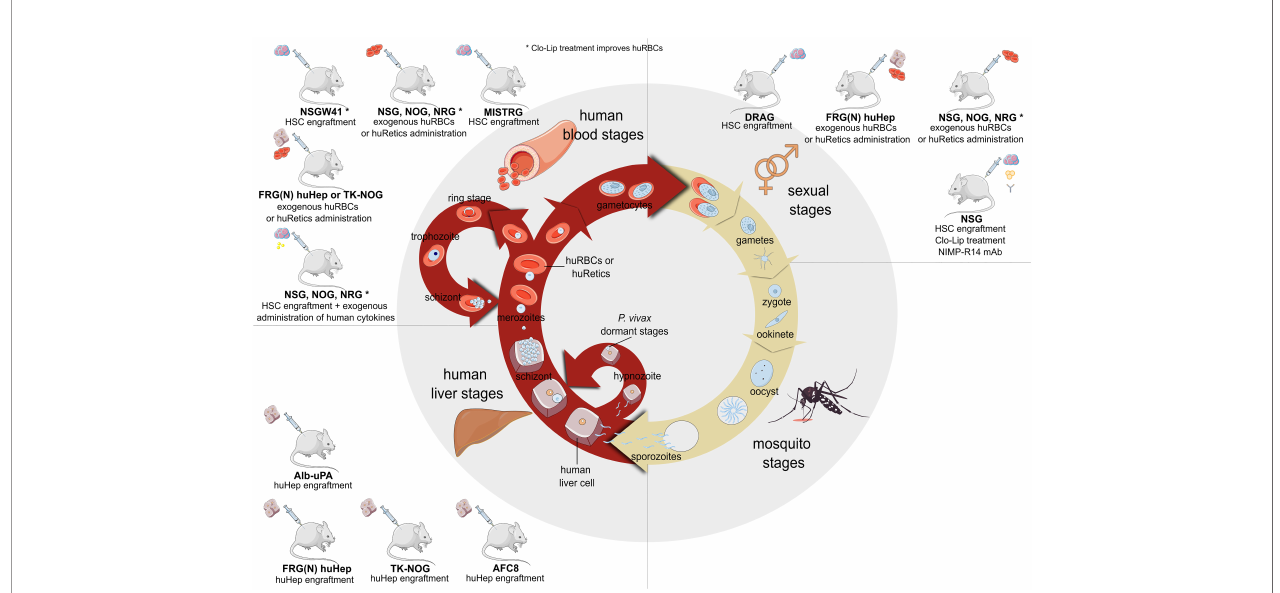
FIGURE 2 | Plasmodium falciparum and Plasmodium vivax life cycle together with the currently available immunode fi cient mouse models to study the different parasite stages. Models available to study liver stages are Alb-uPA, FRG (N) huHep, TK-NOG and AFC8 model (this last one has not already been tested for Plasmodium infections). Models to study blood stages are FRG (N) huHep model with exogenous huRBCs (for Pf infection) or huRetics (for Pv infection) administration; NSG, NOG and NRG models engrafted with human HSCs and treated with exogenous human cytokines or directly administered with exogenous huRBCs (for Pf infection) or huRetics (for Pv infection); NSGW41 (or NBSGW) and MISTRG models engrafted with human HSC (this last one has not already been tested for Plasmodium infections). Models to study sexual stages are DRAG model engrafted with human HSC, FRG (N) huHep model with exogenous huRBCs (for Pf infection) or huRetics (for Pv infection) administration, NSG, NOG and NRG models engrafted with exogenous huRBCs (for Pf infection) or huRetics (for Pv infection), NSG model engrafted with human HSC, treated with Clo-Lip and NIMP-R14 to deplete remaining murine neutrophils. *Clo-Lip treatment improves huRBCs engraftment/development. Human hepatocytes (huhep); human red blood cells (huRBC); human reticulocytes (huRetics); hematopoietic stem cells (HSC); Clodronate liposomes (Clo-Lip); Plasmodium falciparum (Pf); Plasmodium vivax (Pv); albumin-urokinase-type plasminogen activator (Alb-uPA); Knock-out (KO); FAH, Rag2 -/- and IL2r g null (FRG); thymidine kinase NOG (TK-NOG); NOD.Cg-Prkdc scid Il2rg tm1Wjl/ SzJ (NGS); NOD.Cg-Prkdc scid Il2rg tm1Sug/ JicTac (NOG); NOD.Cg-Rag1 tm1Mom Il2rg tm1Wjl/ SzJ (NRG); C;129S4-Rag2 tm1.1Flv Csf tm1(CSF1)Flv Csf2/Il3 tm1.1(CSF2,IL3)Flv Thpo tm1.1(TPO)Flv Il2 gtm1.1Flv Tg(SIRPA)1Flv/J (MISTRG); NOD.Cg-Kit W − 41J Prkdcscid Il2rg tm1Wjl/ WaskJ (NSGW41); HLA-DR4 Rag -/- IL2rg -/- NOD (DRAG). (Created with Inkscape by Iris